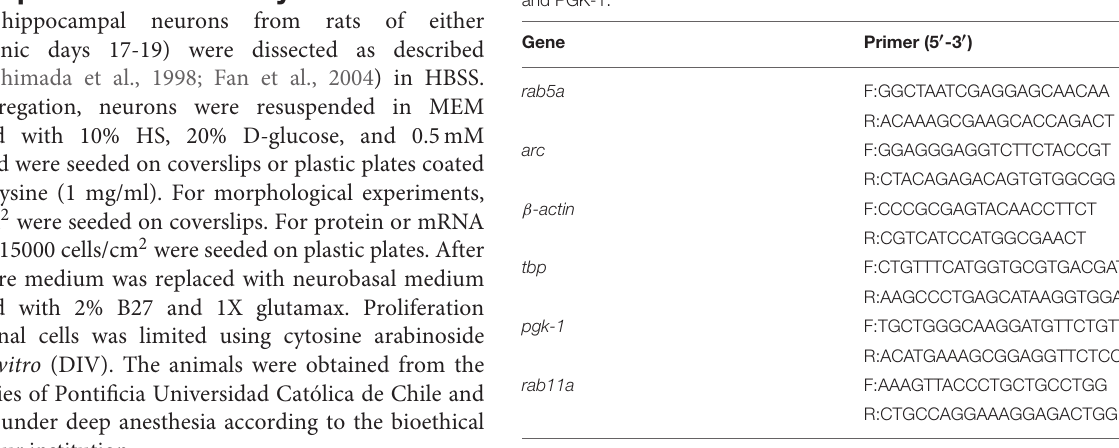
TABLE 1 | Primers used to evaluate the mRNA levels of Rab5a, Arc, β -actin, TBP, and